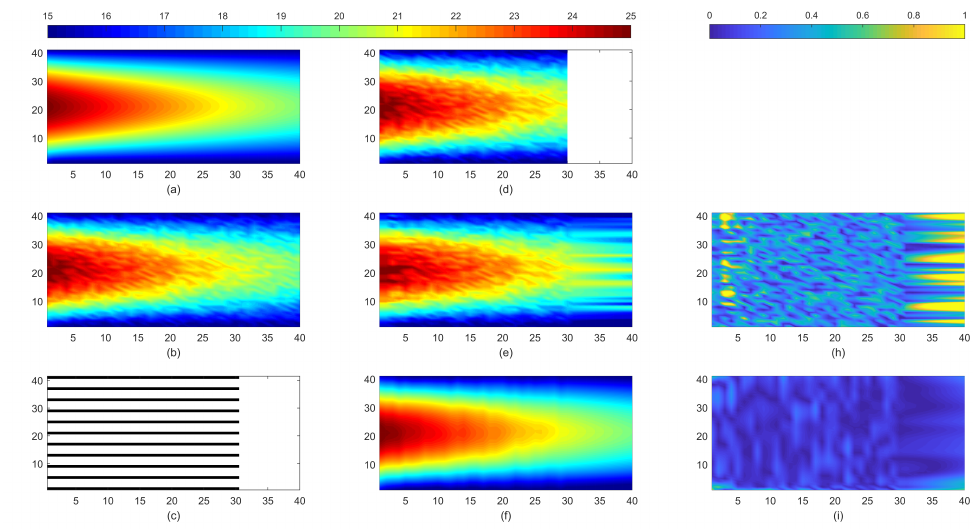
Figure 5. Heat diffusion data at 41 points and 40 time-steps: ( a ) Ground truth; ( b ) Noisy data derived from the real; ( c ) Sample of the noisy data; ( d ) A training area; ( e ) Estimates using Holt-Winters model with training area; ( f ) Estimates using the proposed algorithm with sampled the noisy data; ( h ) Deviation of the Kriging spatial model estimate from the true value; and ( i ) Deviation of our model estimate from the true